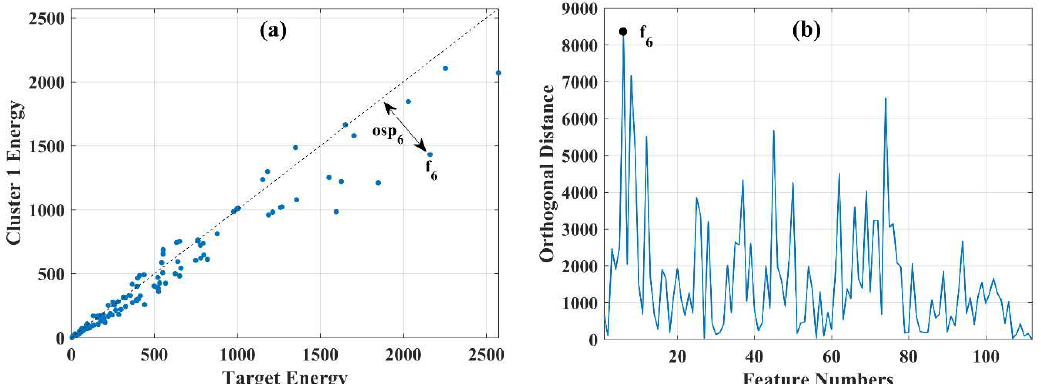
Figure 8. ( a ) Features represented in a 2-dimensional transformed detection space (TDS) built by the target and cluster 1 using all the original feature vectors in the orthogonal subspace projection distance (OSPD) method. 𝒐𝒔𝒑 (cid:2874) is the orthogonal distance vector from feature (𝒇 (cid:2874) ) to the space diagonal. ( b ) The values of the orthogonal distances for all features in the (𝑝 + 1) -dimensional TDS. (𝒇 (cid:2874) ) is the first optimal feature.